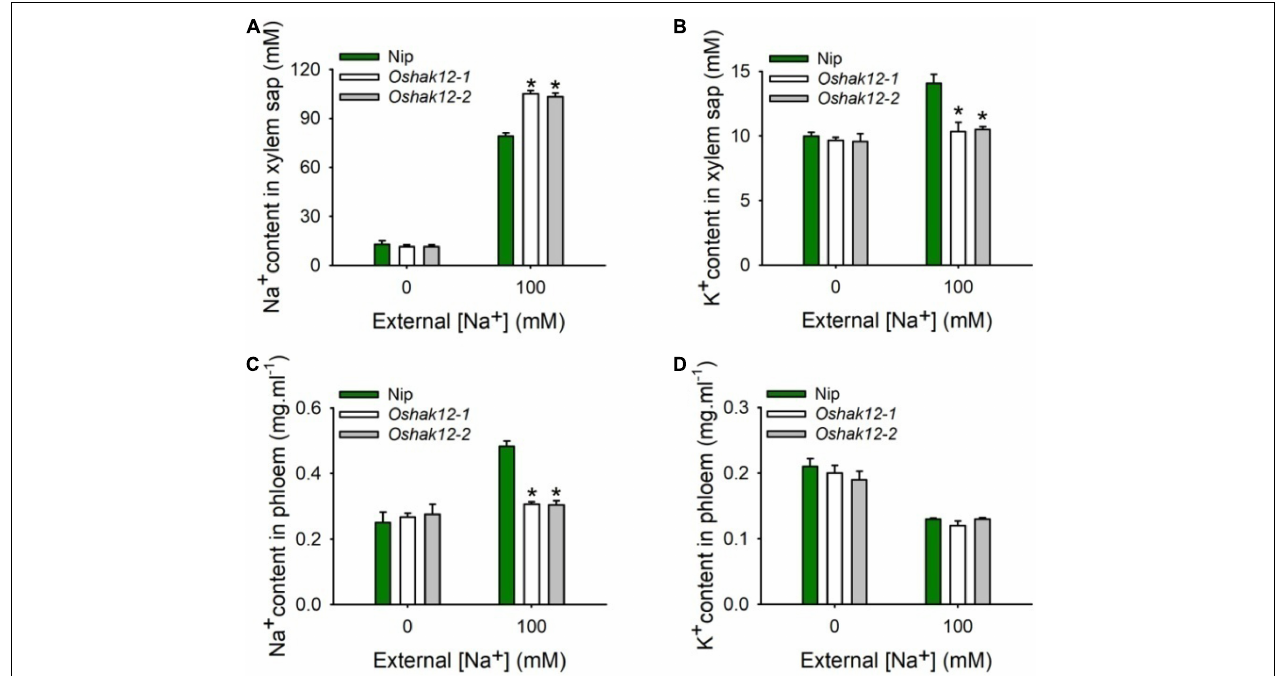
FIGURE 5 | Effects of Oshak12 disruption on Na + and K + ionic contents in xylem sap and phloem sap under salt stress. (A) Na + content in xylem sap. 5-days-old rice seedlings were cultivated in the solutions for 14 days and then transferred to the hydroponic cultures containing 0 or 100 mM Na + for 2 days. The Nip and Oshak12 mutants ( Oshak12-1 , Oshak12-2 ) plants showed significant differences ( n = 30 for each data point) (* P < 0.005 by Student’s t -test). (B) K + concentration in xylem sap. Cultivation conditions were as described in (A) . The Nip and Oshak12 mutants plants showed significant differences ( n = 30 for each data point) (* P < 0.01 by Student’s t -test). (C) Na + concentration in phloem. Growth conditions were as described in (A) . Na + concentration were examined by ICP-MS. The Nip and Oshak12 mutants plants showed significant differences ( n = 30 for each data point) (* P < 0.005 by Student’s t -test). (D) K + concentration in phloem. Growth conditions were as described in (A) . K + concentration were examined by ICP-MS. The Nip and Oshak12 mutants plants showed no significant differences ( n = 30 for each data point) ( P > 0.05 by Student’s t -test). The methods for the shoot excision, collecting the xylem sap and phloem secretion, examining Na + and K + concentration by ICP-MS were described previously by Tian et al. (2021). The experiment was repeated four times with similar results. Data are means of 20 replicates of one experiment. Asterisks represent significant differences. Error bars represent ± SD.